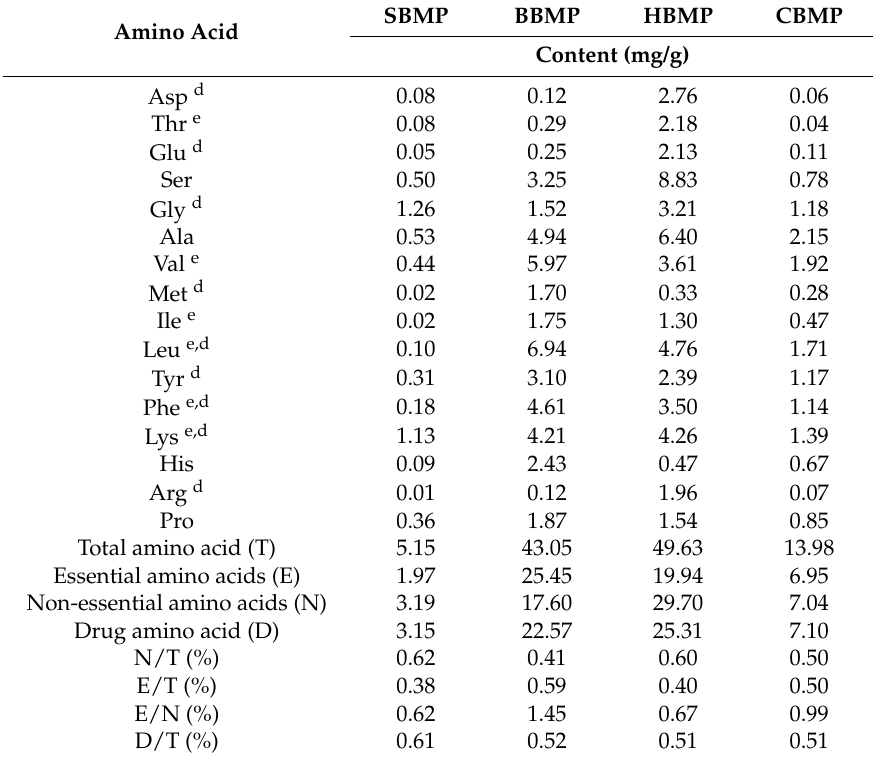
Table 4. The composition and contents of free amino acids in four kinds of water extract BMP. Amino Acid